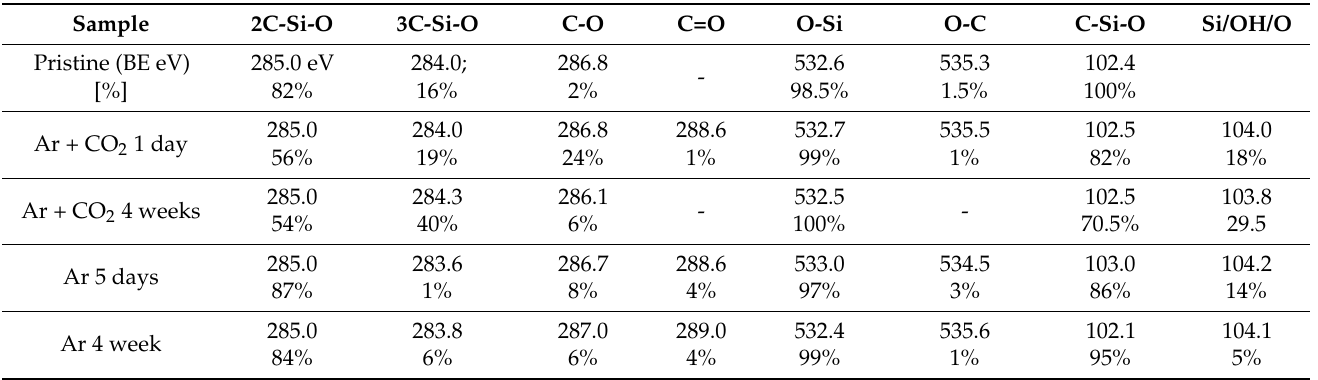
ification in the plasma results from increased content of the polar oxygen groups C-O